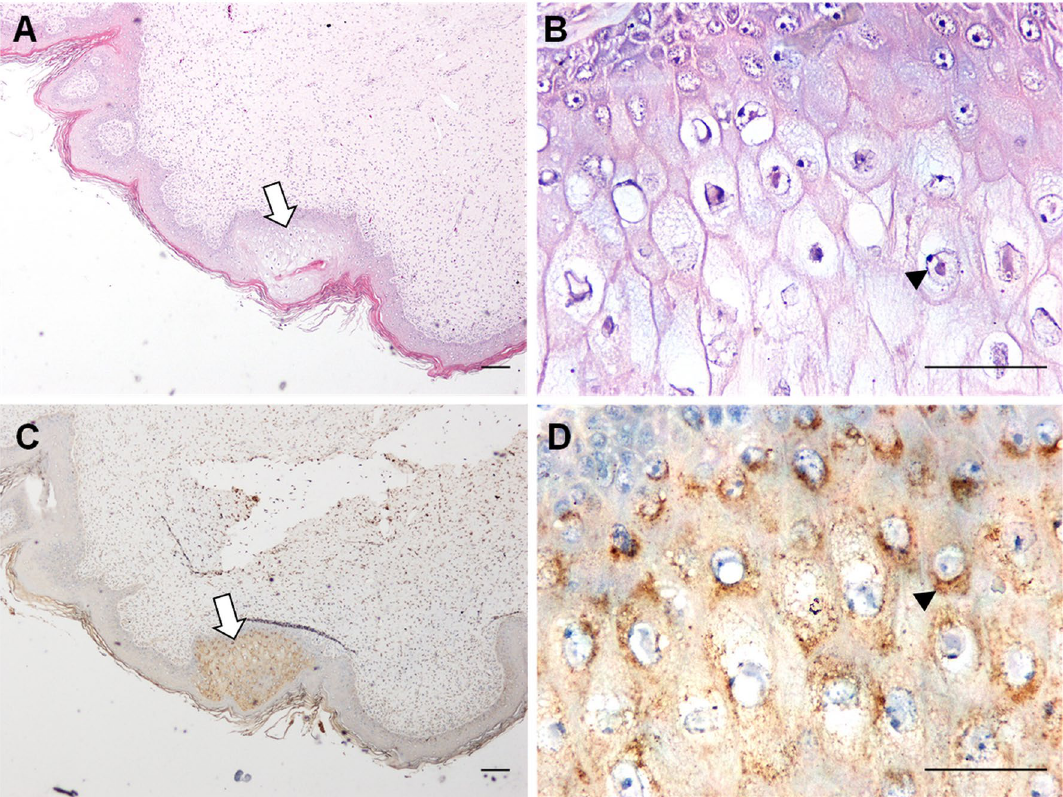
Figure 5. Reactivity of anti-serum F2 with FP-bearing sea turtle skin by IHC. Skin tissue sections derived from sea turtles (G46) with FP were stained with hematoxylin–eosin reagent (Panels A , B ) or with mouse anti-sera F2 (Panels C , D ). The white arrow and black arrowhead indicate ballooning degeneration and inclusion bodies, respectively, in the tumor tissues. The scale bar in each image indicated 100